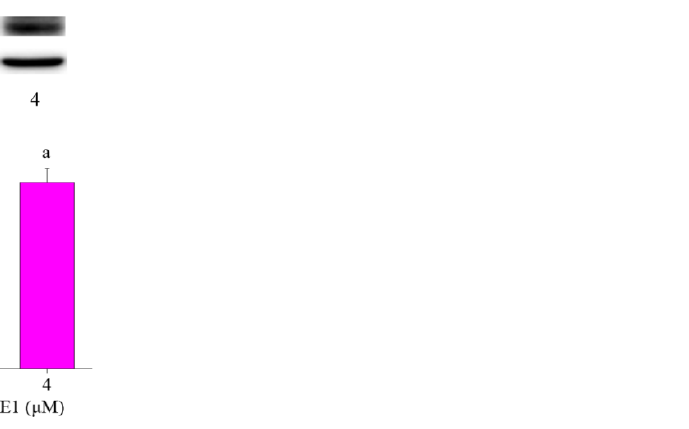
Figure 4. Effect of TSE1 on the TGR5 protein expression in STC-1 cells at 24 h. Protein levels were detected by Western blot, and analyzed by the ImageJ software. Different letters indicate significant difference among groups ( p < 0.05).